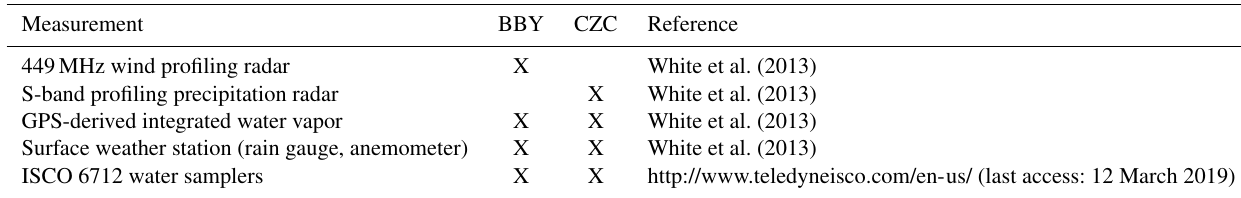
Table 1. Atmospheric river observatory (ARO) measurements by site (Bodega Bay, CA: BBY; Cazadero, CA: CZC). Measurement BBY